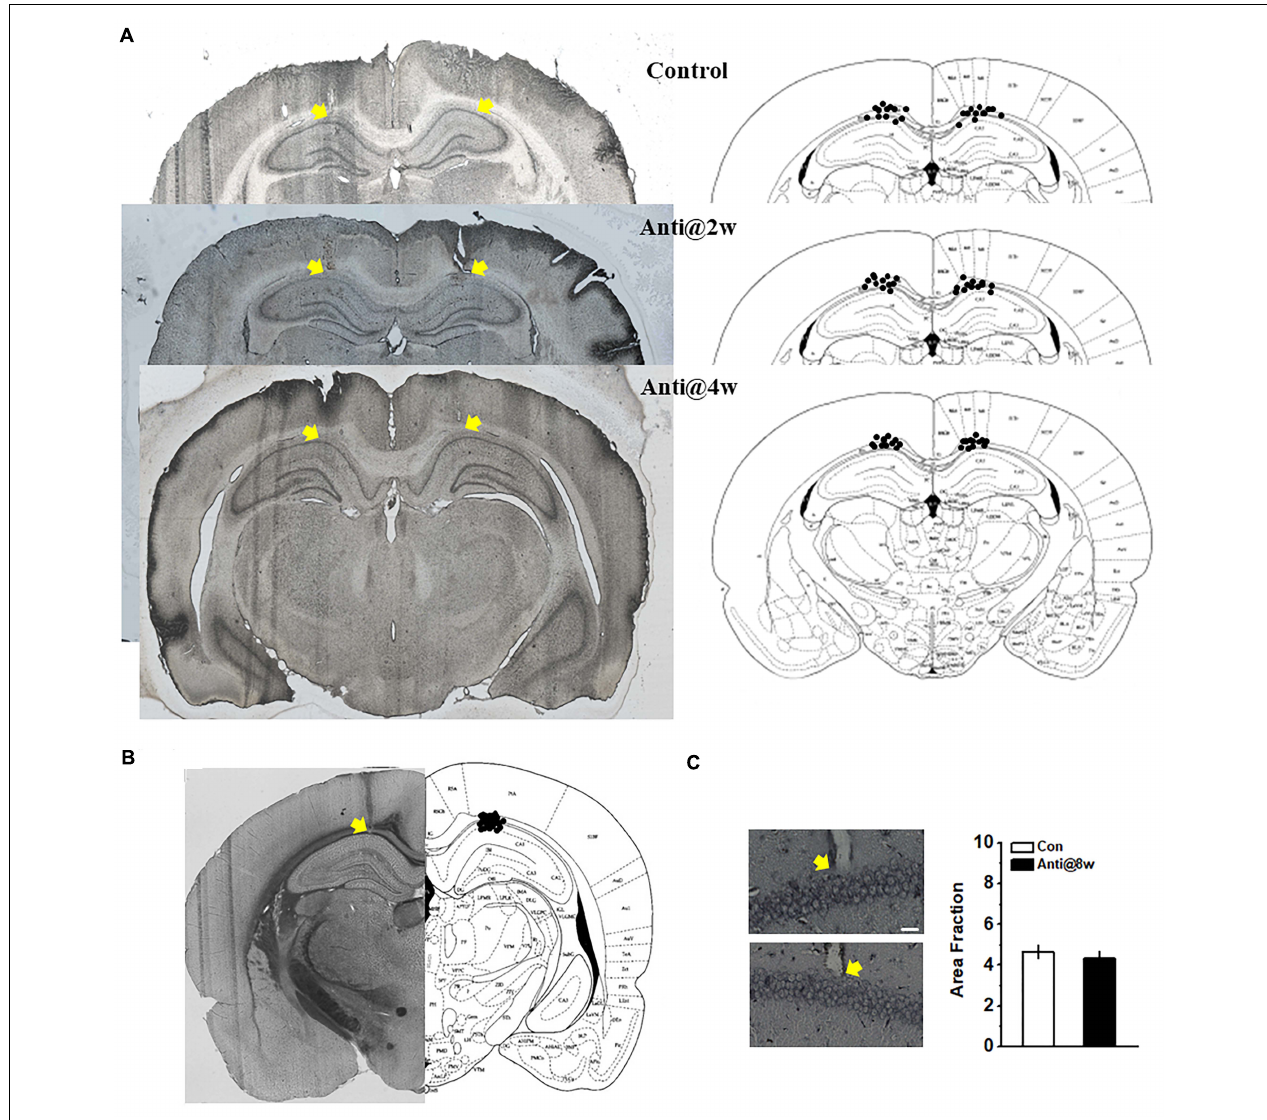
FIGURE 1 | Schematic representations of the cannulae and electrode placements and morphological alterations in the CA1 region. (A) Histological (left) and schematic (right) representations of the cannula placements. The control group infused with ACSF throughout the whole PD4w; the Anti@2w and Anti@4w groups were infused with anti-proBDNF antibody throughout the whole second and fourth postnatal weeks, respectively. The yellow arrows indicated the top of the cannulae. (B) Histological and schematic representations of electrode placements. (C) Following the open field test, infusion-induced neuronal damage was assessed by Silver staining (see Supplementary Methods ). The white scale bar presented at the bottom of the photomicrograph indicated 25 µ m. The yellow arrows indicated the electrode tips. There was no statistical difference in the quantification of neurodegeneration in CA1 neurons between the control (top) and anti-proBDNF (bottom) groups. The anti-proBDNF group was infused with anti-proBDNF antibody throughout the whole fourth postnatal week. The control group was treated with the same volume of the vehicle (ACSF) throughout the whole the fourth postnatal week. The treatment was conducted twice a day in a 12-h interval. n = 6 for each group.